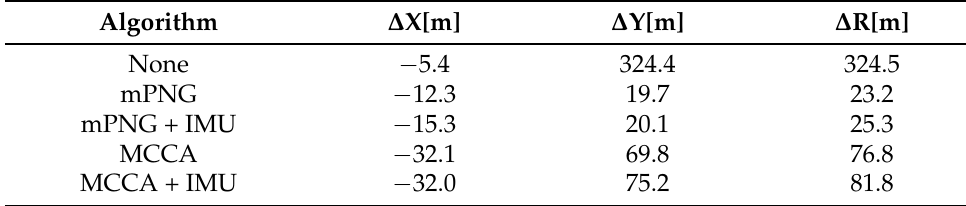
Table 2. The errors in landing point components.